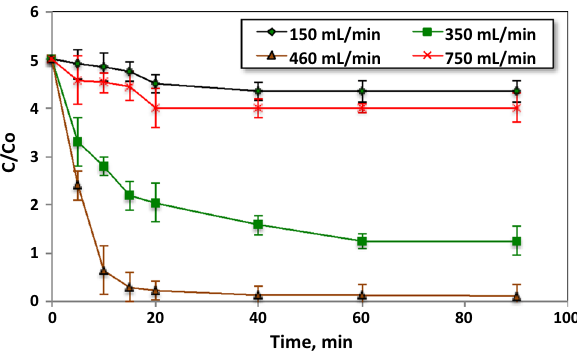
Fig. 5 Effect of the solution flow rate on the photodegradation pro-